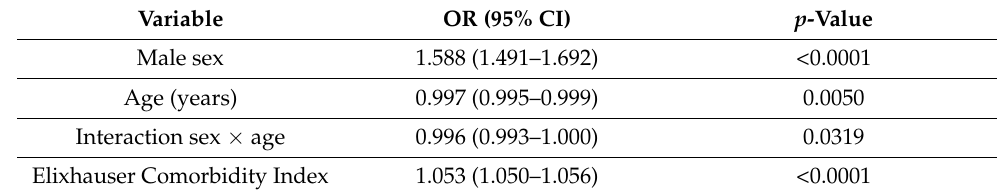
Table 4. Results of Multivariable Analysis of the Probability of Intensive Care.